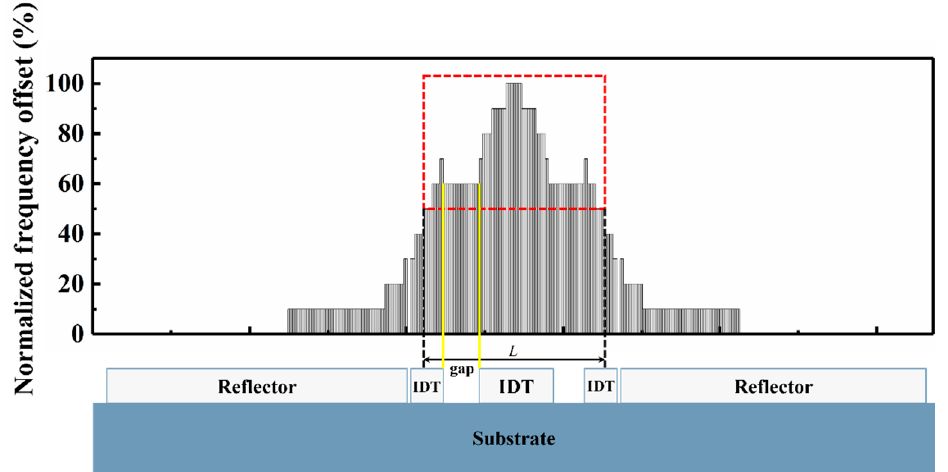
Figure 6. The normalized sensitivity distribution of the SAWR’s surface to the mass loading effect .